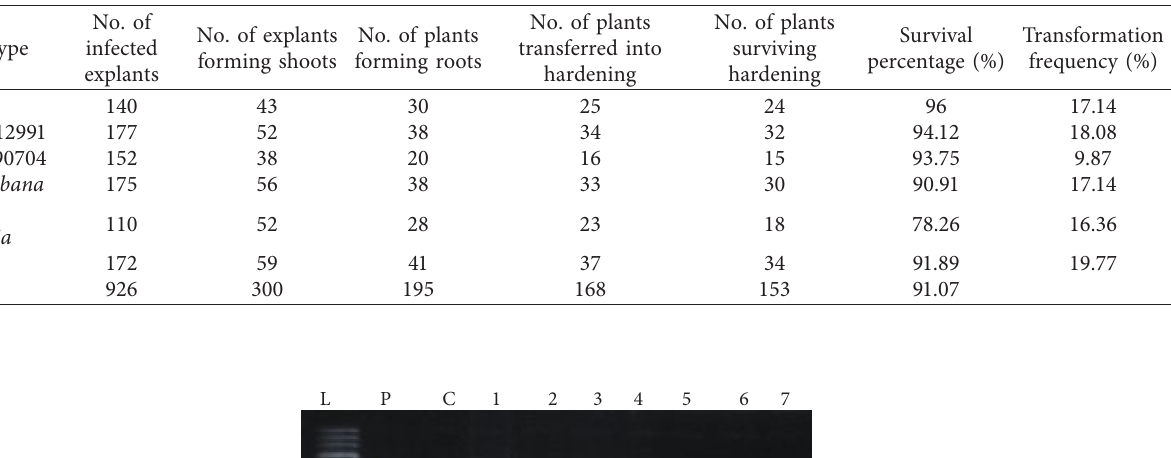
Figure 2: Profile of shooting of Red Valencia explants in selection media. The arrow shows shoots of the surviving Table 1: Number of explants in different stages.